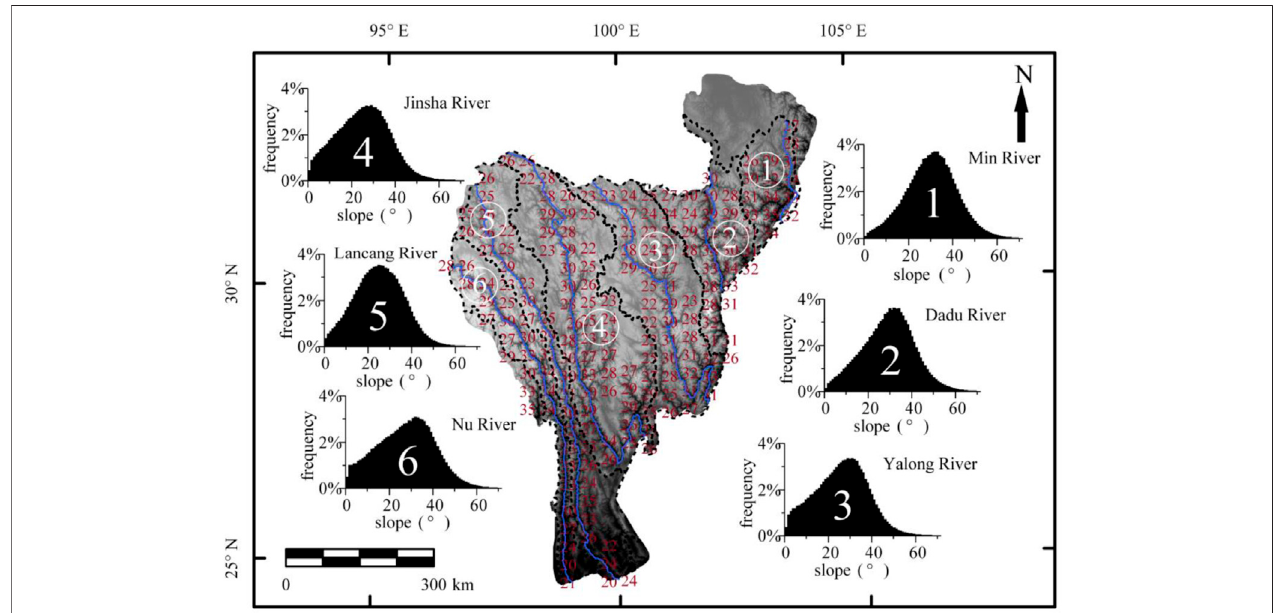
FIGURE 3 | Slope of the study area and the slope frequency distribution of each river drainage.